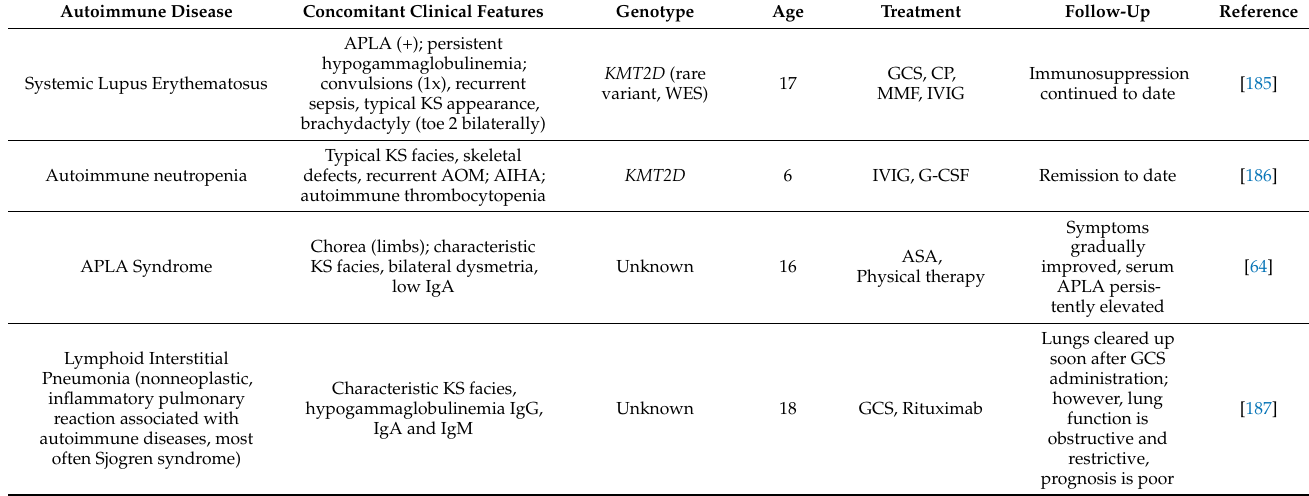
Rare autoimmune manifestations reported in the literature. APLA—Antiphospholipid Antibody; AOM—Acute Otitis Media; AIHA—Autoimmune Hemolytic Anemia; ASA—Acetylsalicylic Acid; CP—Cyclophosphamide; GCS—Glucocorticosteroids; G-CSF—Granulocyte Colony Stimulating Factor; IVIG—Intravenous Immunoglobulins; MMF—Mycophenolate Mofetil, WES – Whole Exome